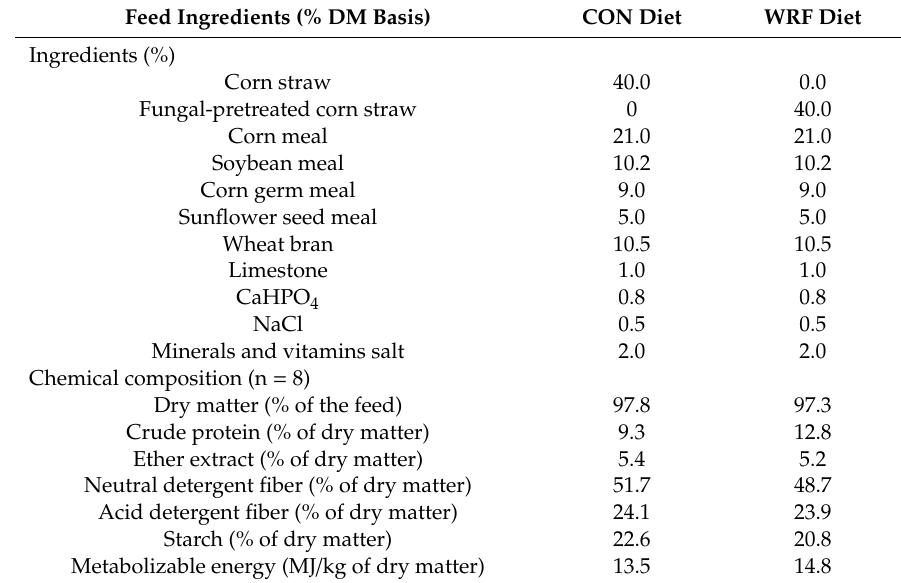
Table 1. Ingredients and chemical composition of the experiment’s